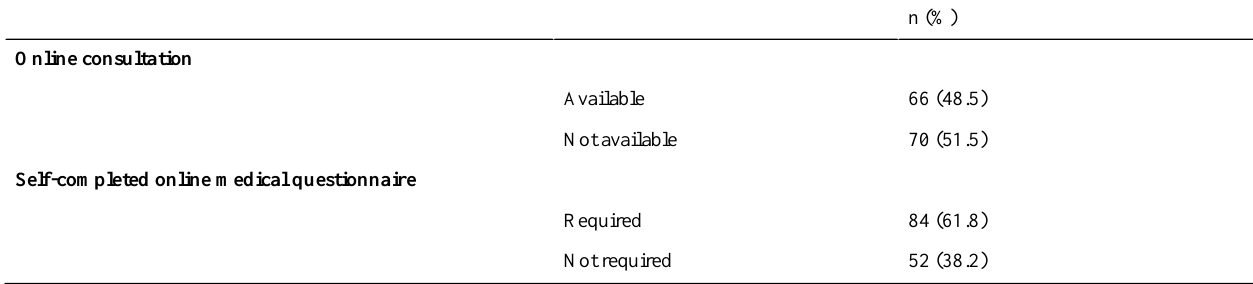
Table 1. Sources of medical information exchange on Internet pharmacy websites (N=136).